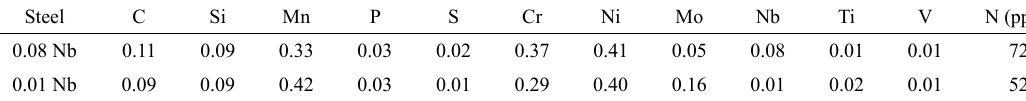
Table 1. Chemical compositions of microalloyed steels (% in weight). Steel